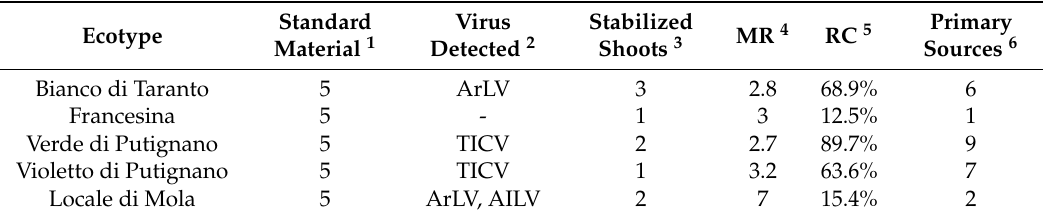
Table 2. Viruses detected in the off-shoots of globe artichoke ecotypes collected from farmers and their multiplication rates (MR) and rooting capacity (RC) obtained during the sanitation protocol.